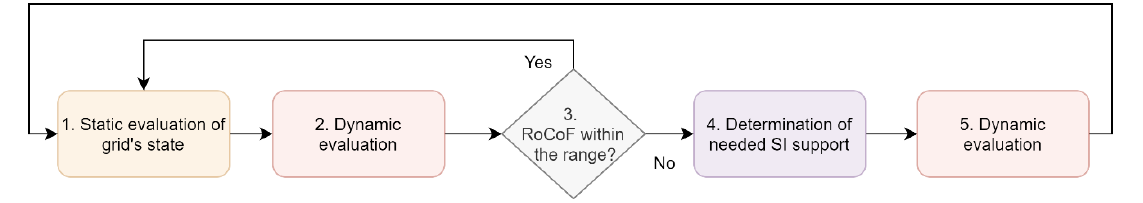
Figure 5. Response to generation trip of 1. purely inertial system (grey line); 2. inertial system with synthetic inertia (SI support exhibiting linear decline of frequency in the first 0.5 s (red line); 3. same as no. 2 but with governor action (dashed line).